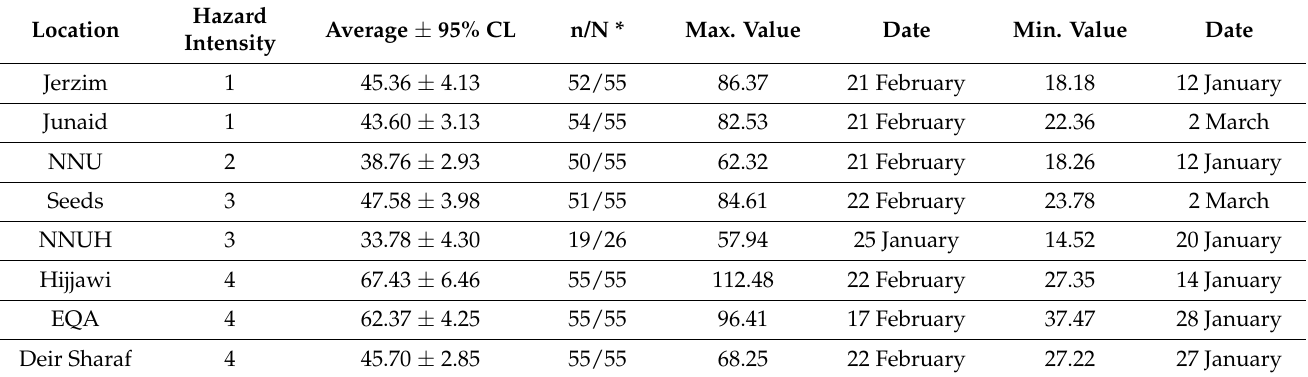
Table 2. Average, maximum, and minimum PM 2.5 values (in µ g/m 3 ) in the eight sampling locations.